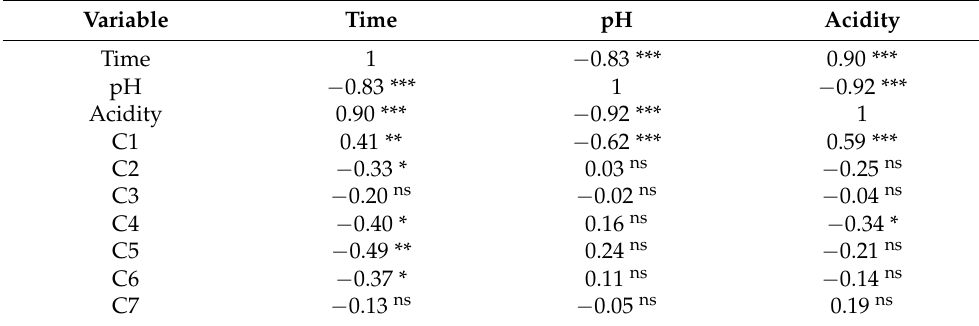
Table 2. Correlation matrix and significance level between variables and compounds. Variable Time pH Acidity Time 1 − 0.83 ***